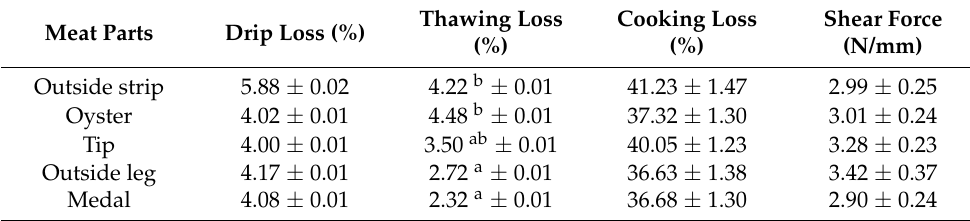
Table 9. Technological characteristics and shear force of the five valuable meat parts ( n = 10).